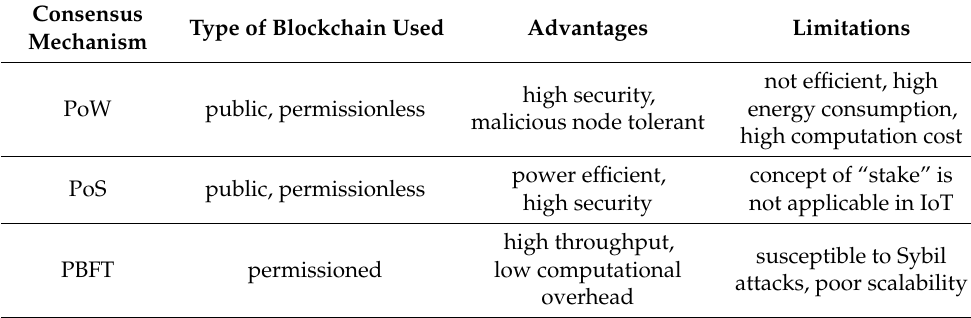
Table 1. Comparison of consensus